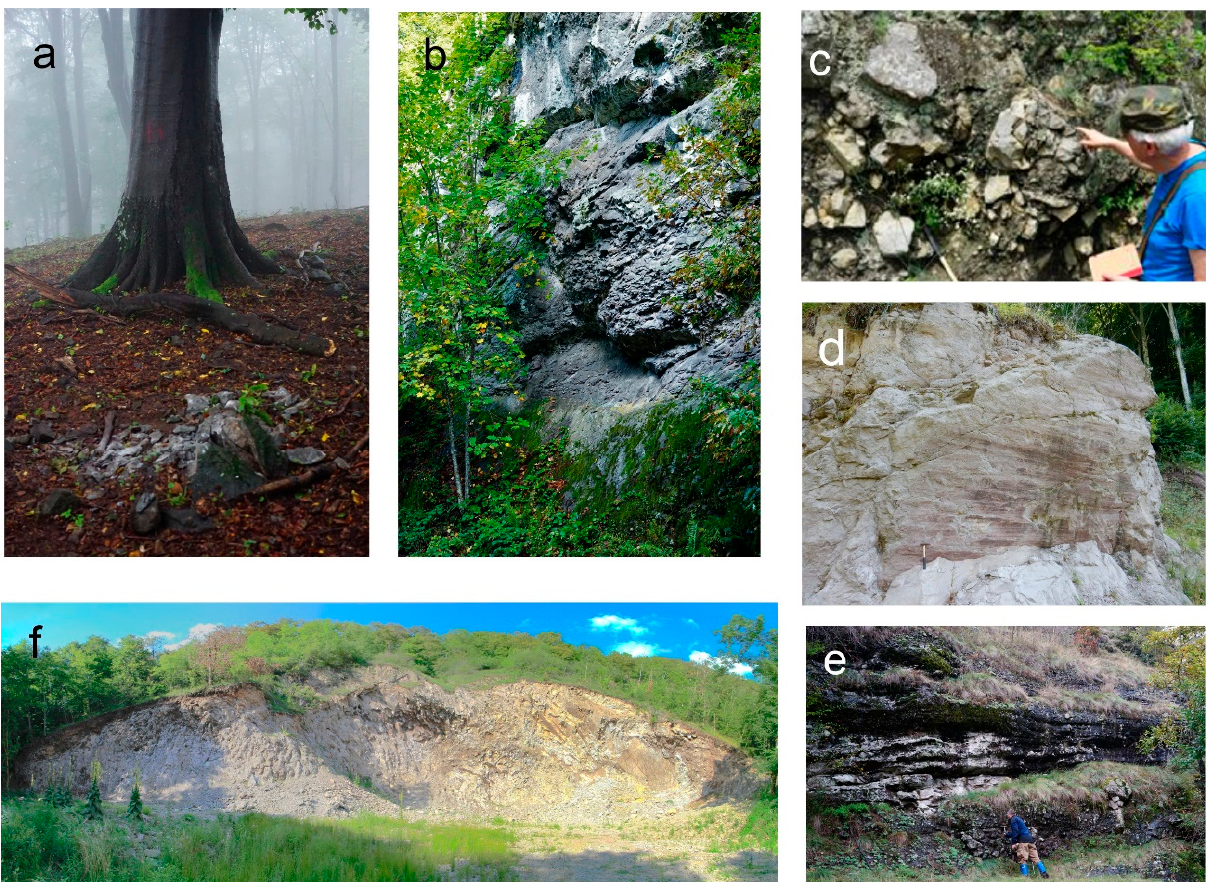
Figure 6. ( a ) Small lava dome outcrop exposed in the top of V ă ratec peak; to note poor exposure; ( b ) Succession of pyroxene andesite lava flows on the Bont ă u valley (CVW part of the volcano); ( c ) Outcrop of block facies debris-avalanche deposit viewing exclusive angular blocks and clasts of various sizes, some of them showing jigsaw cracks (WDA); ( d ) Several meters clast in block facies debris avalanche showing sub-horizontal slickenside (WDA); ( e ) Sequences in stratified debris flows deposits, of dm to m size, (WDA); ( f ) quarry in a strongly deformed and crushed large dome-type colossal block (150 m wide) of amphibole (±pyroxene) andesite (WDA).